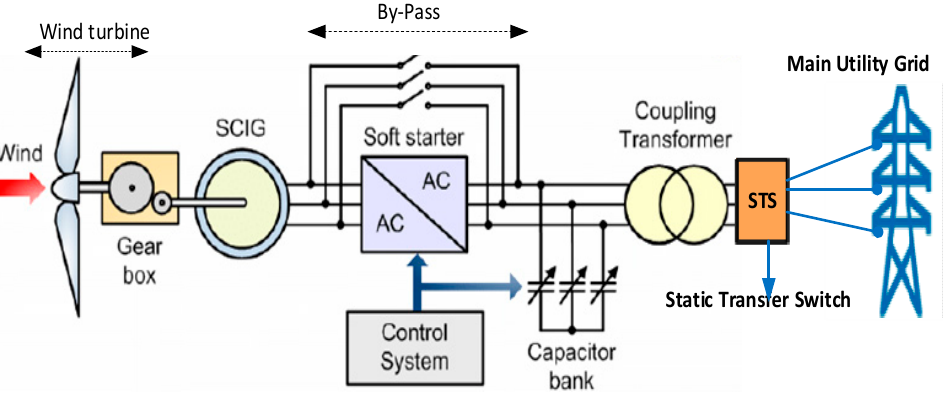
Figure 5. Schematic diagram of a wind turbine with a fixed speed.